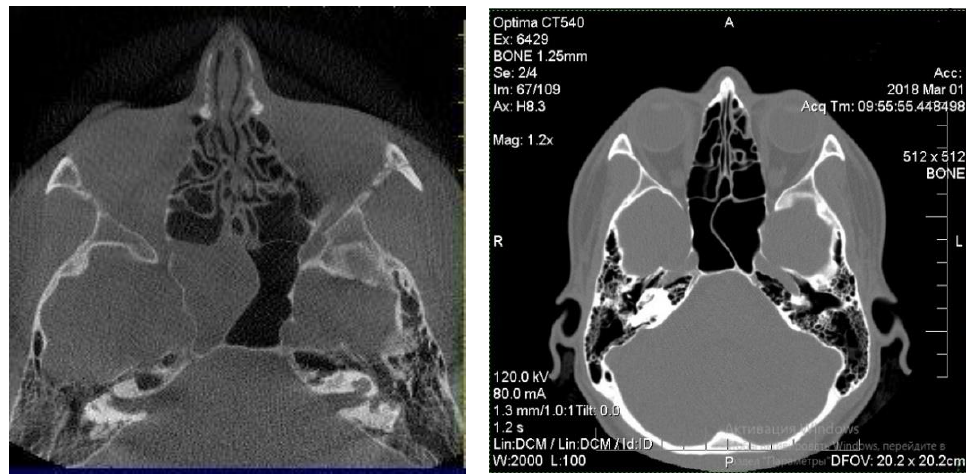
Figure 2. CT-scan of a patient, who showed good outcomes after conservative treatment and was added to group